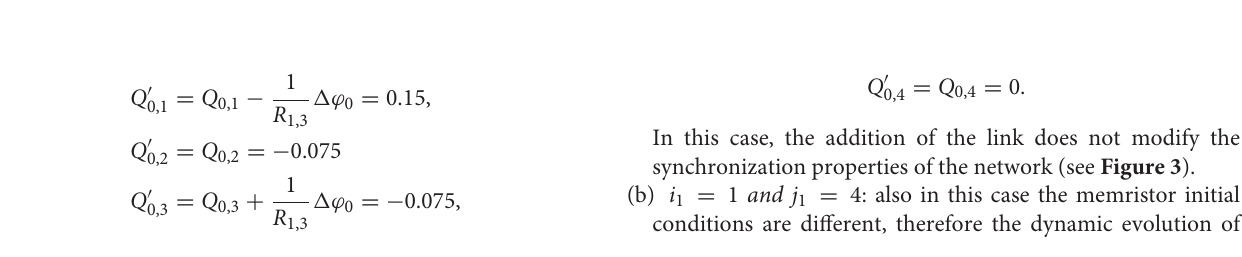
FIGURE 2 | (A) Phase portrait and (B) time series of a network of four diffusively coupled MOCs. The oscillators are nearly in-phase synchronized except for the fourth one.